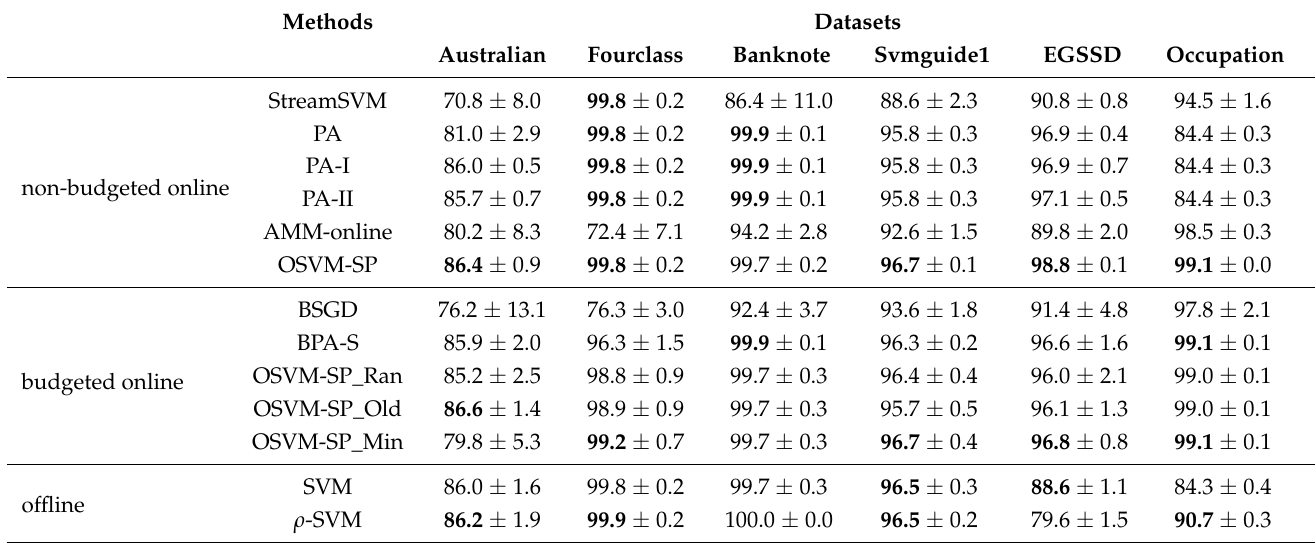
Table 4. Classification accuracy (mean ± STD, %) with best results shown in